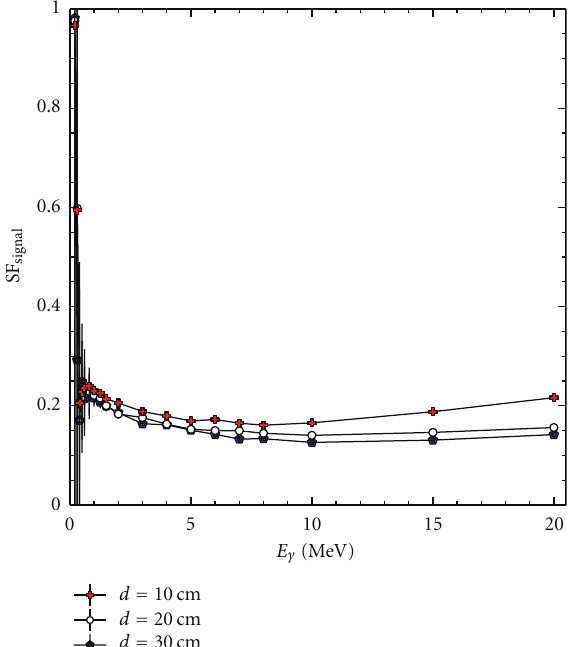
Figure 10: The signal scatter fraction for CPID response per pixel as a function of X-ray energy.